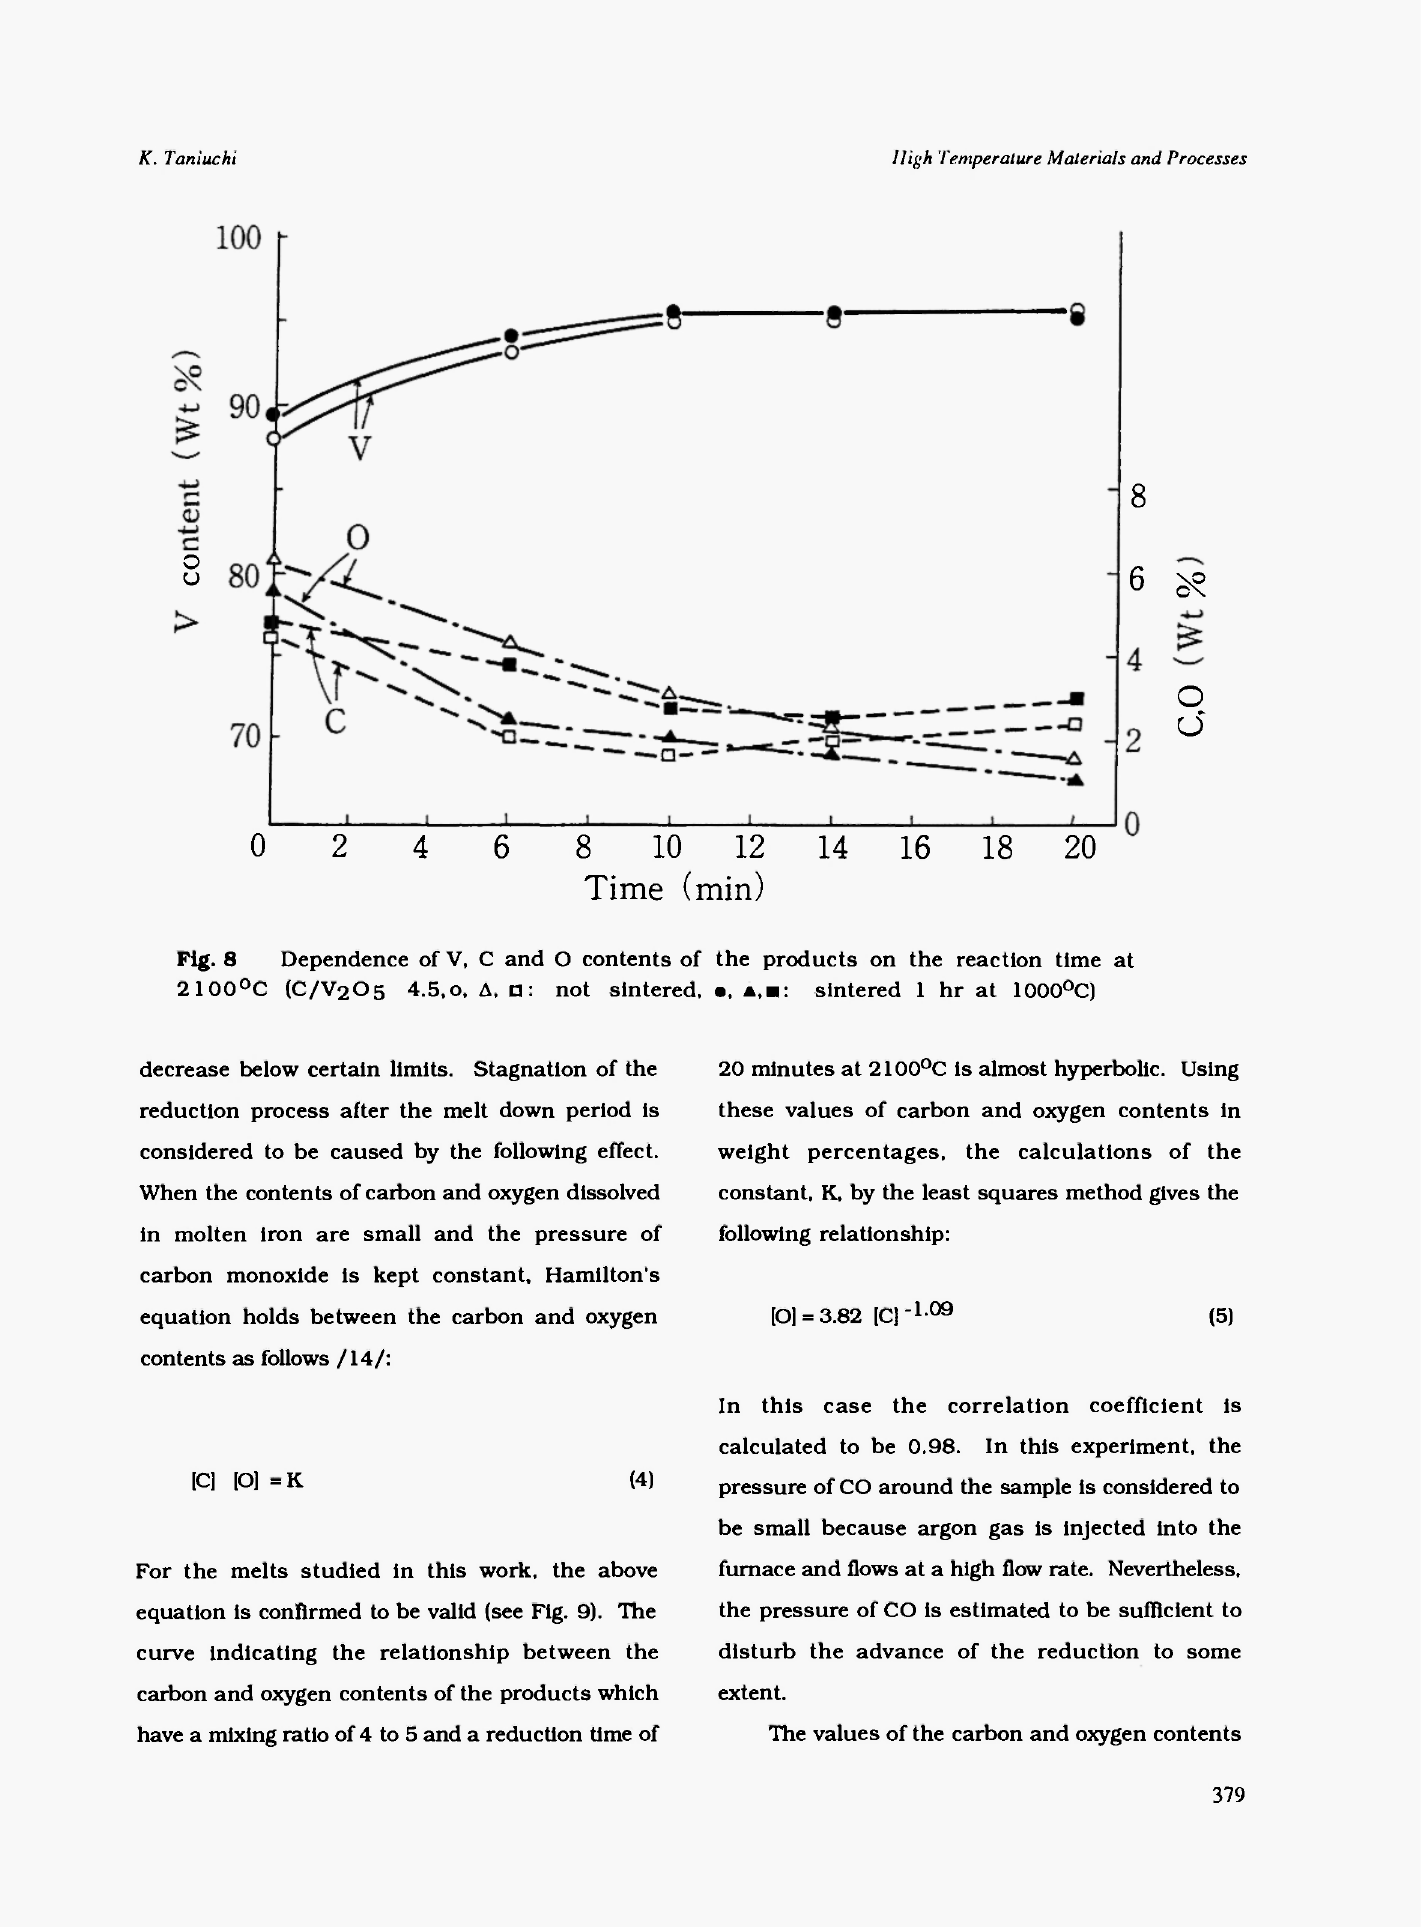
considered to be caused by the following